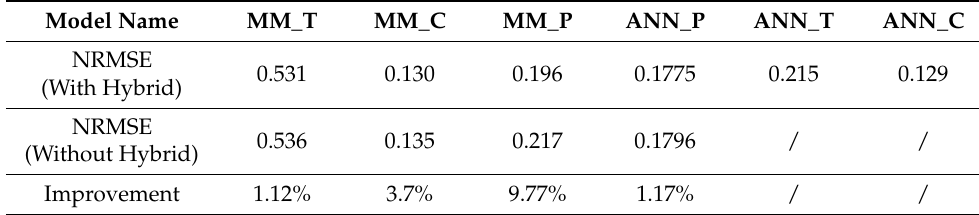
Table 10. Model evaluations of the hybrid models and non-hybrid models.